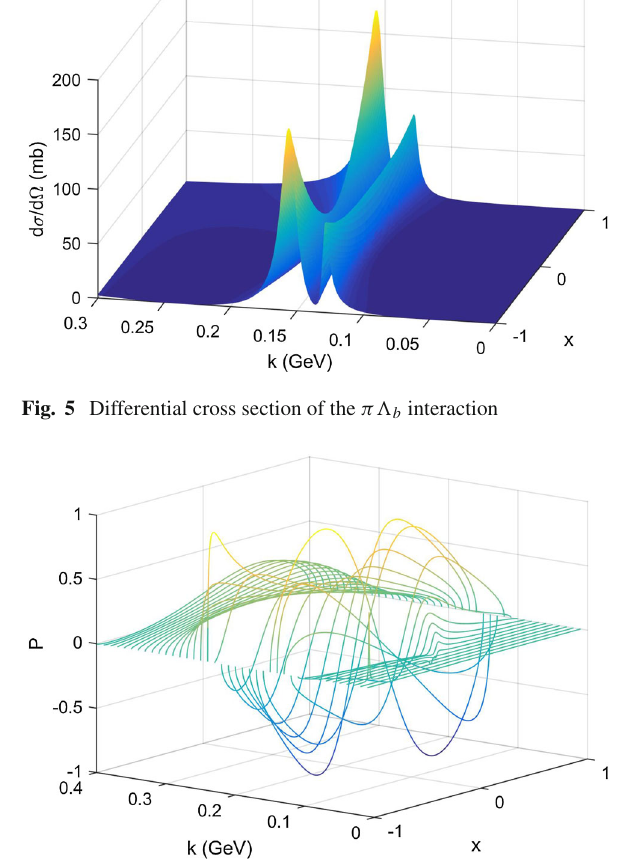
Fig. 6 Polarization in the π(cid:2) b interaction